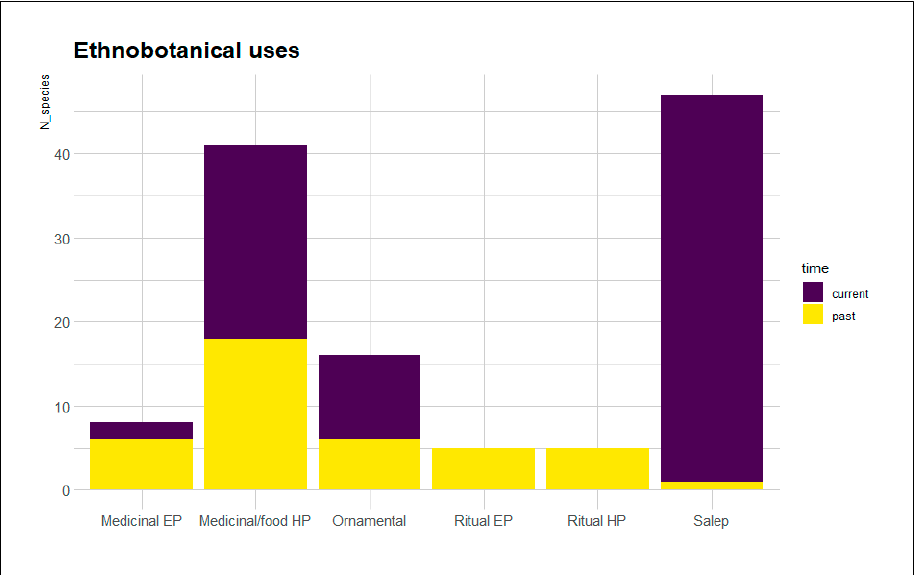
Figure 1. Comparison between past and current uses of European orchids. EP: epigean portion; HP: hypogean portion.